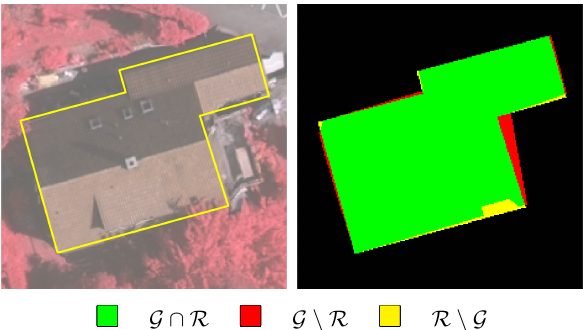
Figure 9. Evaluation of the unconstrained acquisition Q from QGIS compared to the ground truth G .